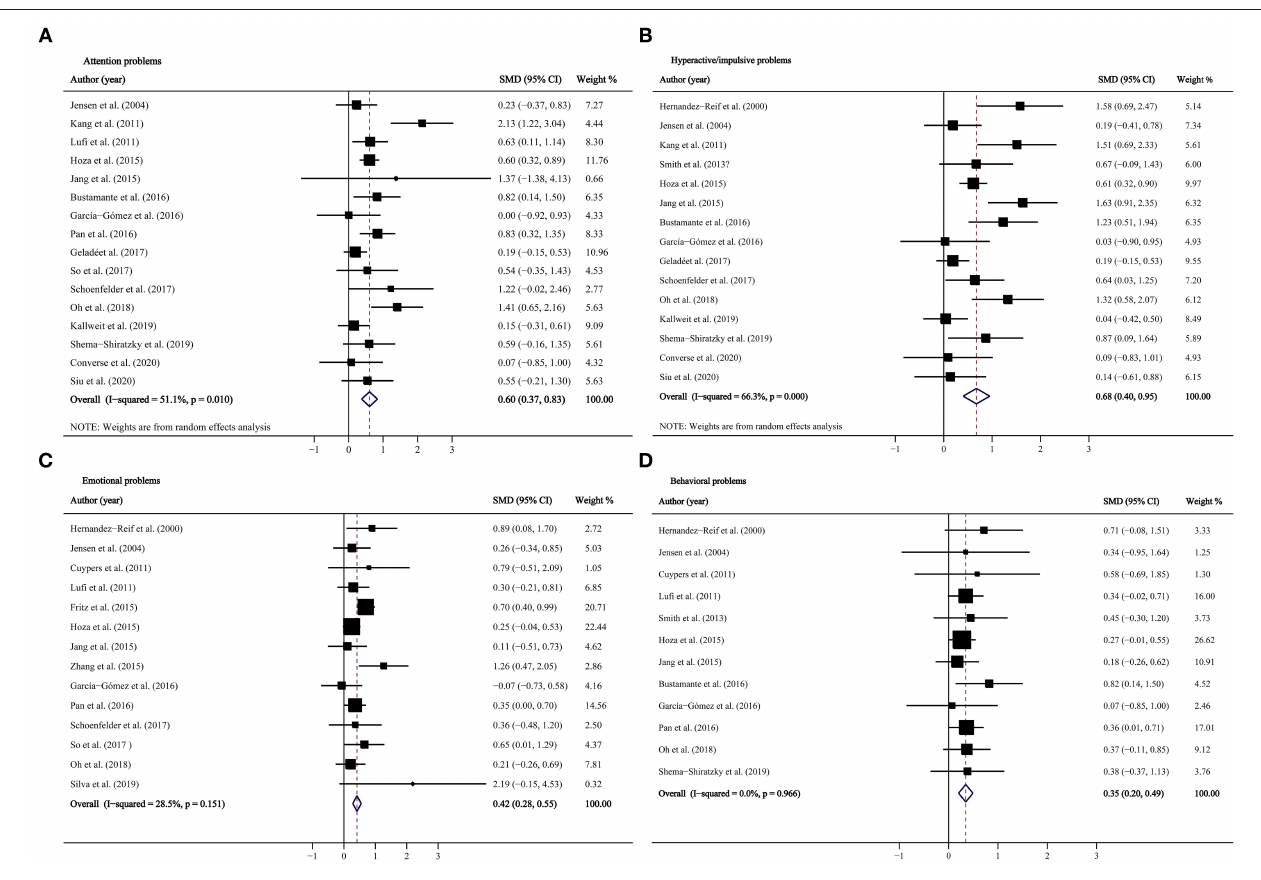
FIGURE 2 | Forest plots for physical activity intervention on ADHD symptoms in before–after studies. (A) Attention problems; (B) hyperactive/impulsive problems; (C) emotional problems; (D) behavioral problems. CI, confidence interval; SMD, standardized mean difference.